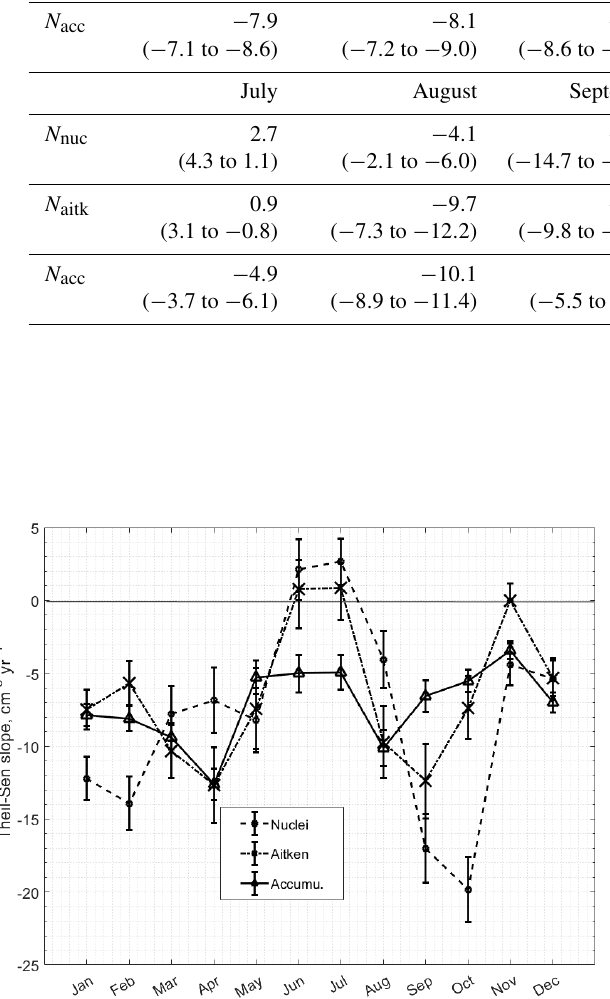
Figure 10. Theil–Sen estimator slopes for annual trend per month for fitted number concentration of nuclei, Aitken and accumulation modes, January–December 2000–2017. Indicated by error bars are upper and lower confidence intervals of slopes at σ (0.05). All trends are tested with the Mann–Kendall test and shown to be significant for σ = 0 . 05 except the Aitken mode trend during June–July and November. Upper and lower CIs calculated following Hollander and Wolfe (1973).